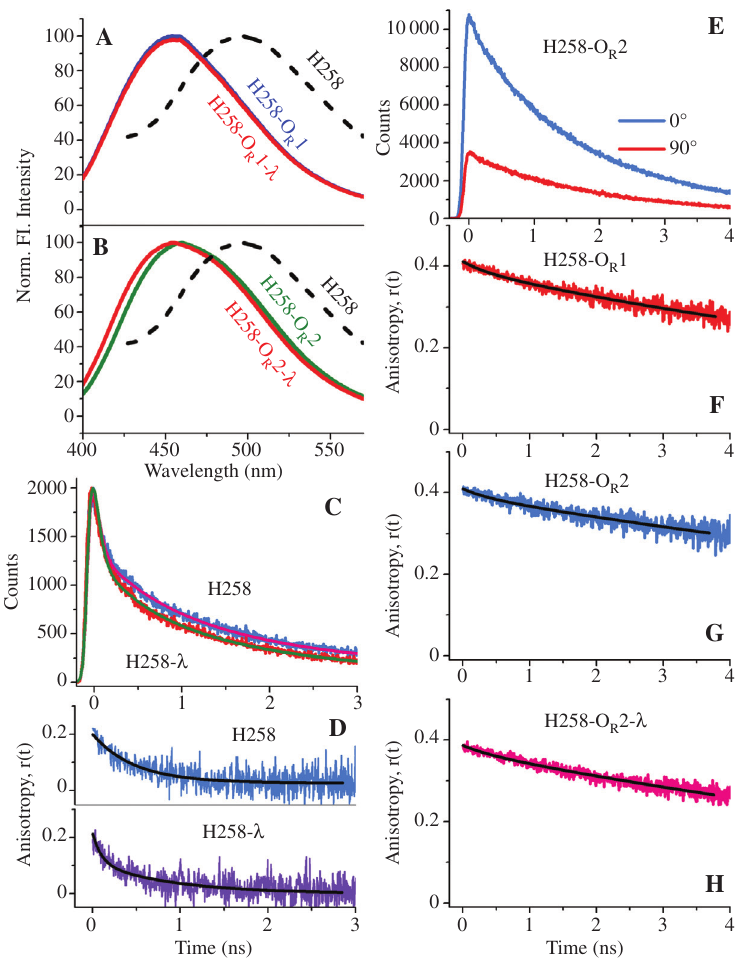
Figure 13 Normalized steady-state fluorescence spectra of probe H258 in three different environments. 1 DNA and O 1-repressor complex. (B) In buffer, O 2 DNA and O 2-repressor complex. (C) Picosecond-resolved fluorescence (A) In buffer, O R R R R transients of H258 is shown in presence λ -repressor protein. For comparison, the fluorescence transient of H258 in buffer solution is also included. (D) Time-resolved fluorescence anisotropies, r(t), of the probe in water (buffer) and in presence λ -repressor protein at emission wavelength of 500 nm are shown. (E) Representative time-resolved traces of H258 in O 2 at different polarization (0 0 and 90 0 ) is shown. R Time-resolved fluorescence anisotropies of H258 in O 1 (F) and O 2 (G) are depicted. (H) Represents the anisotropy decay of H258 in O 2- R R R protein complex. [Reprinted with permission from ref. (31) Copyright 2013, Elsevier with λ -repressor, CD spectroscopy was used. Figure 14 rep- 1 (upper decreases (72% to 59%), whereas in case of O R resents the CD spectra of operator DNA, O panel), the efficiency remains unaltered (57%). The FRET 1 and O 2 in the R R study clearly demonstrates that O absence and in the presence of λ -repressor. In the case of 2 DNA undergoes sig- R O nificant conformation change upon protein binding, 2 (Figure 2B), careful observation reveals a shift of the R leading to the decrease in energy transfer efficiency. The spectral maximum (270 nm) along with the increase in ellipticity upon complexation with λ -repressor. In the case which also indicates the structural changes within O of O 1 DNA (Figure 14A), a negligible spectral shift and a 2 R R smaller change in ellipticity was observed in comparison to O from the excited state of H258 to EtBr molecules, it is 2. The observation indicates the conformational R change of O 2 after binding to the repressor is significant R compared to that of O 1. The time-resolved fluorescence R can influence the energy transfer rate as observed from transients are represented in Figure 15(B). As evident, the time-resolved fluorescence studies (50). In this from Figure 15(B; lower panel), upon addition of repressor context, a kinetic model developed by Tachiya (51) for the to O 2, the efficiency of energy transfer from H258 to EtBr R